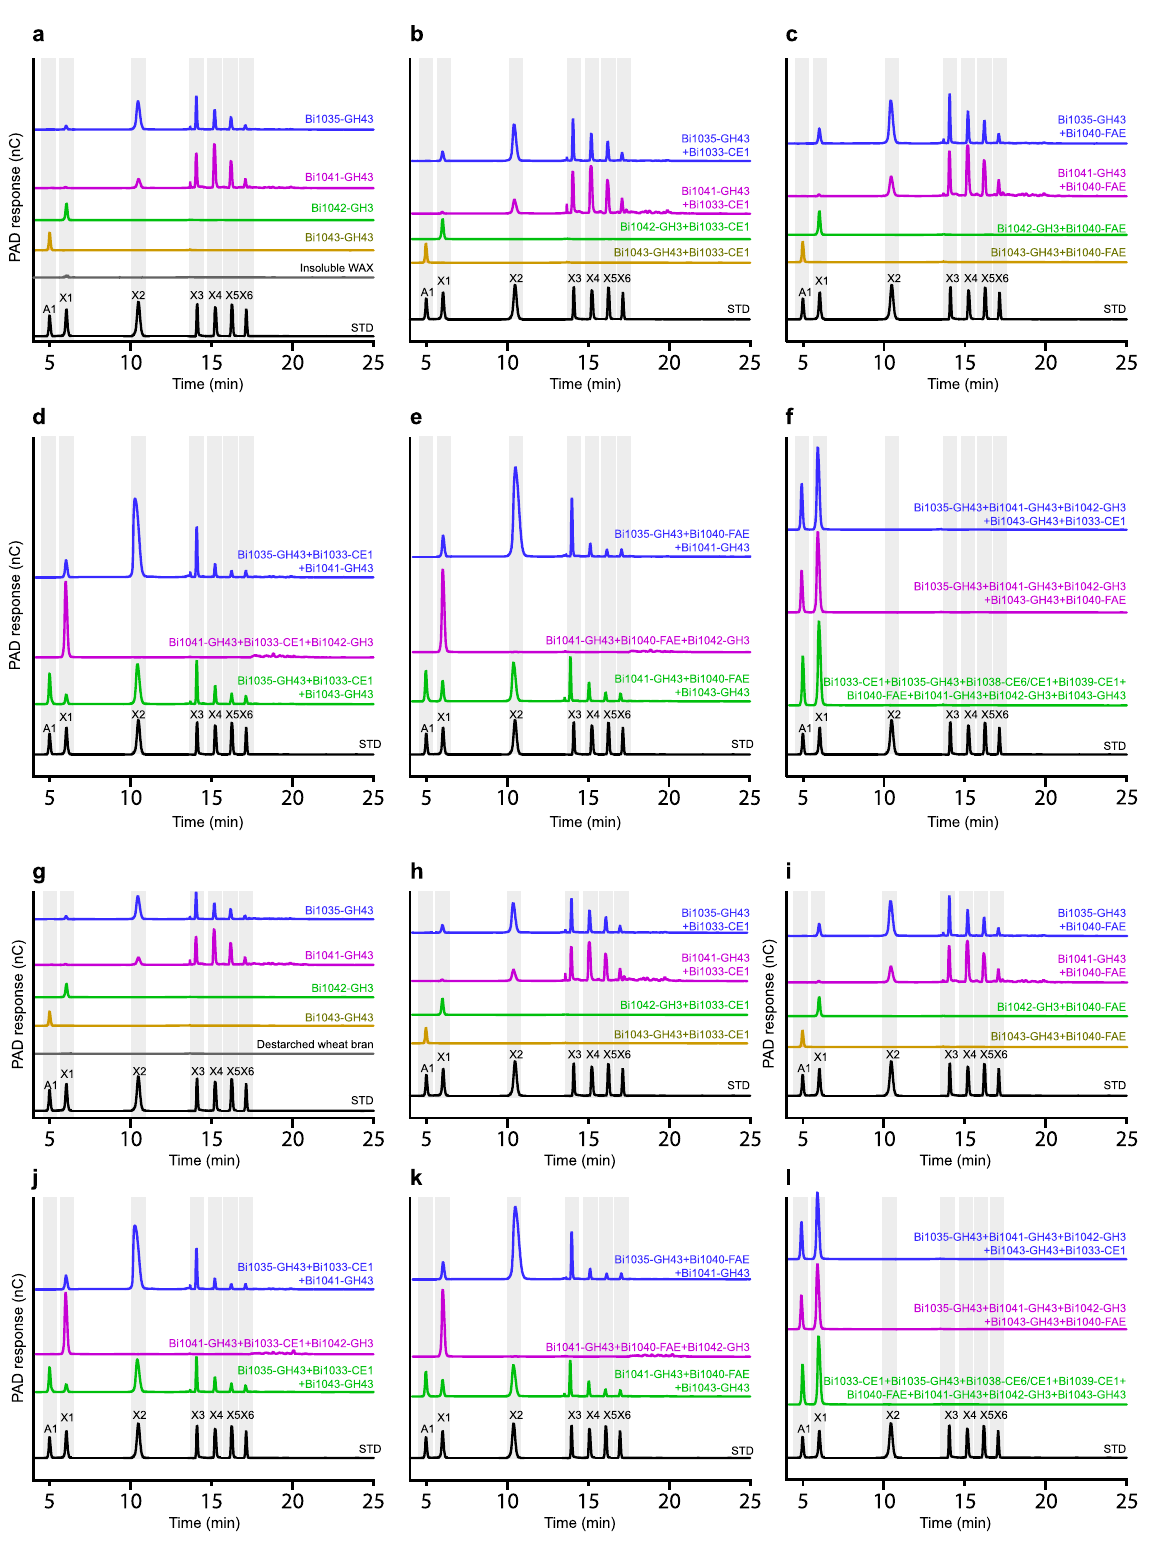
The crystal structures of Bi1039-CE1 and Bi1033-CE1 were also determined to observe the differences in enzyme speci fi city (see Supplementary Table 1 for the X-ray data collection and re fi nement statistics). The structure of Bi1039-CE1 included residues 25 – 382 (1.74 Å, R w = 18.2, R f = 21.6%) with